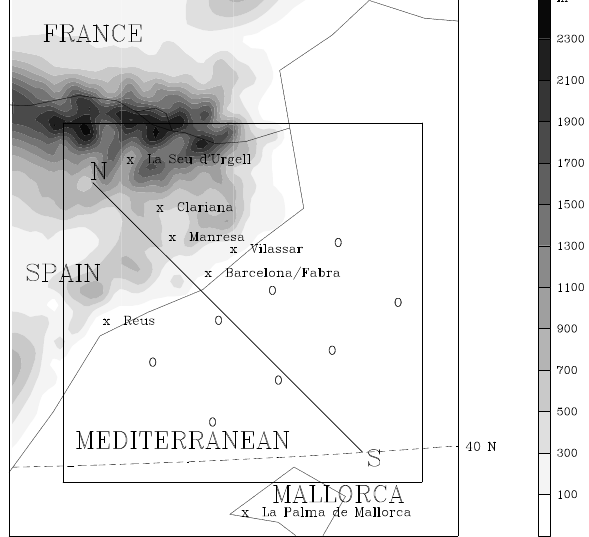
Fig. 3. Map of the third and inner domain. This map covers the northeastern part of the Iberian Peninsula and includes the topog- raphy of the region. The positions of the observations stations are marked with crosses and their respective names. The drawn square marks the area used to investigate the precipitation as calculated by the simulations (see Sect. 4). The circles over sea are the se- lected grid points used to investigate the various PBL variables (see Sect. 5). The line starting with S and ending with N indicates the di- rection and horizontal length of the vertical cross section discussed in Sect. 5.